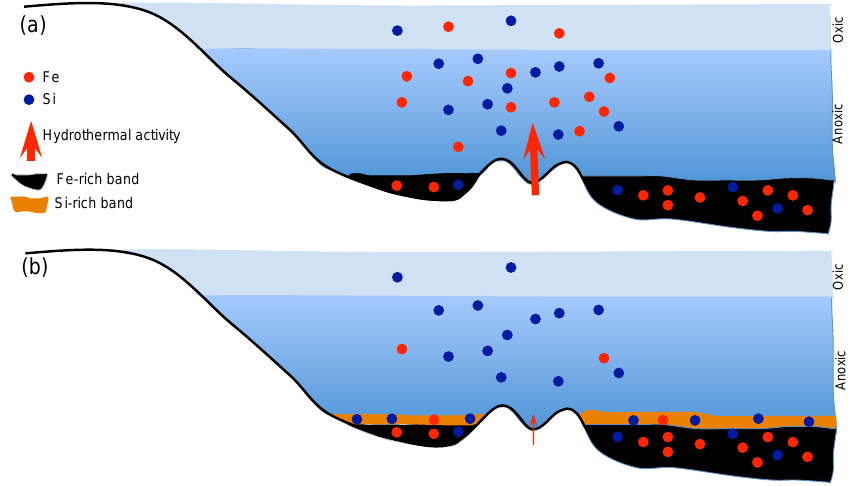
Figure 16. Conceptual model for band formation of the NFIF, related to changes in the intensity of hydrothermal activity and chemical oxidation of Fe(II) to Fe(III) in the water column, inferred from the data. See Chi Fru et al. (2013) for a biological model for the formation of the